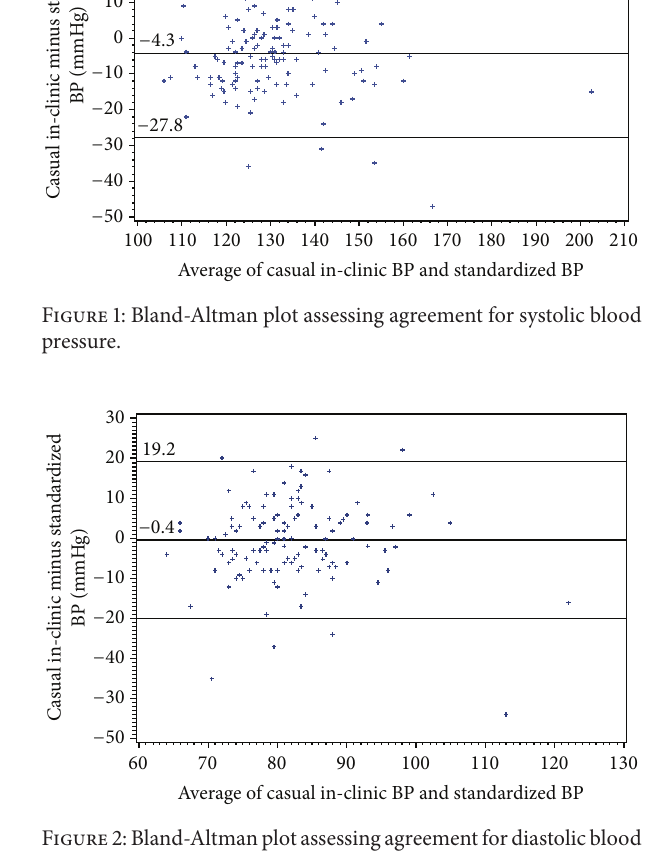
Figure2:Bland-Altmanplotassessingagreementfordiastolicblood